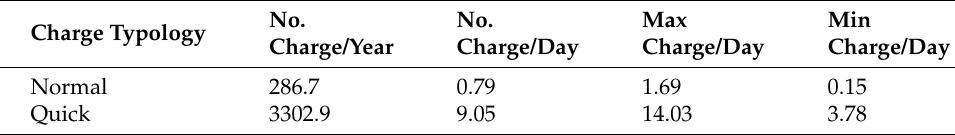
Table 2. Usage rate of charging points for different typologies.